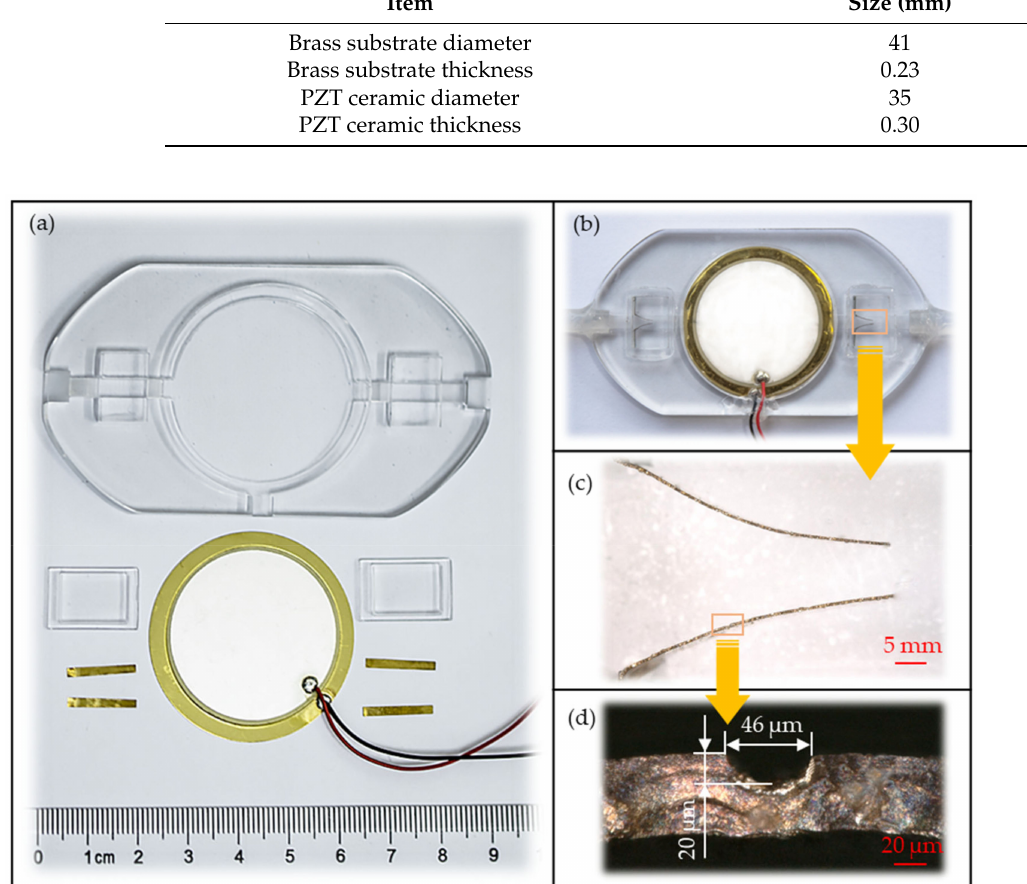
Figure 4. The PPFV: ( a ) Parts and components of the pump; ( b ) the assembled prototype; ( c ) enlarged view of the valve; ( d ) a hinge of the